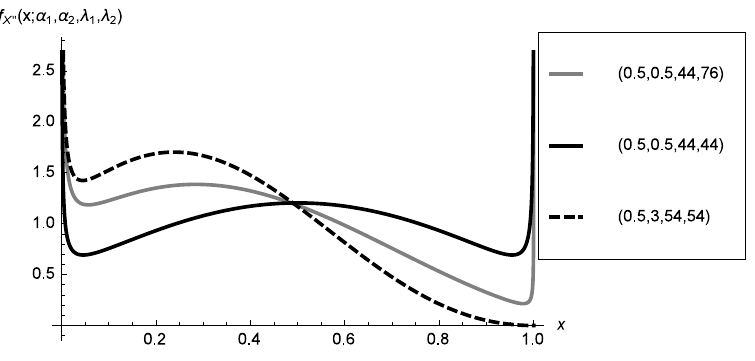
Figure 8 { Plots of the density of X ′′ (cid:24) CDNCB ( (cid:11) 1 ; (cid:11) 2 ; (cid:21) 1 ; (cid:21) 2 ) for selected values of ( (cid:11) 1 ; (cid:11) 2 ; (cid:21) 1 ; (cid:21) 2 ).